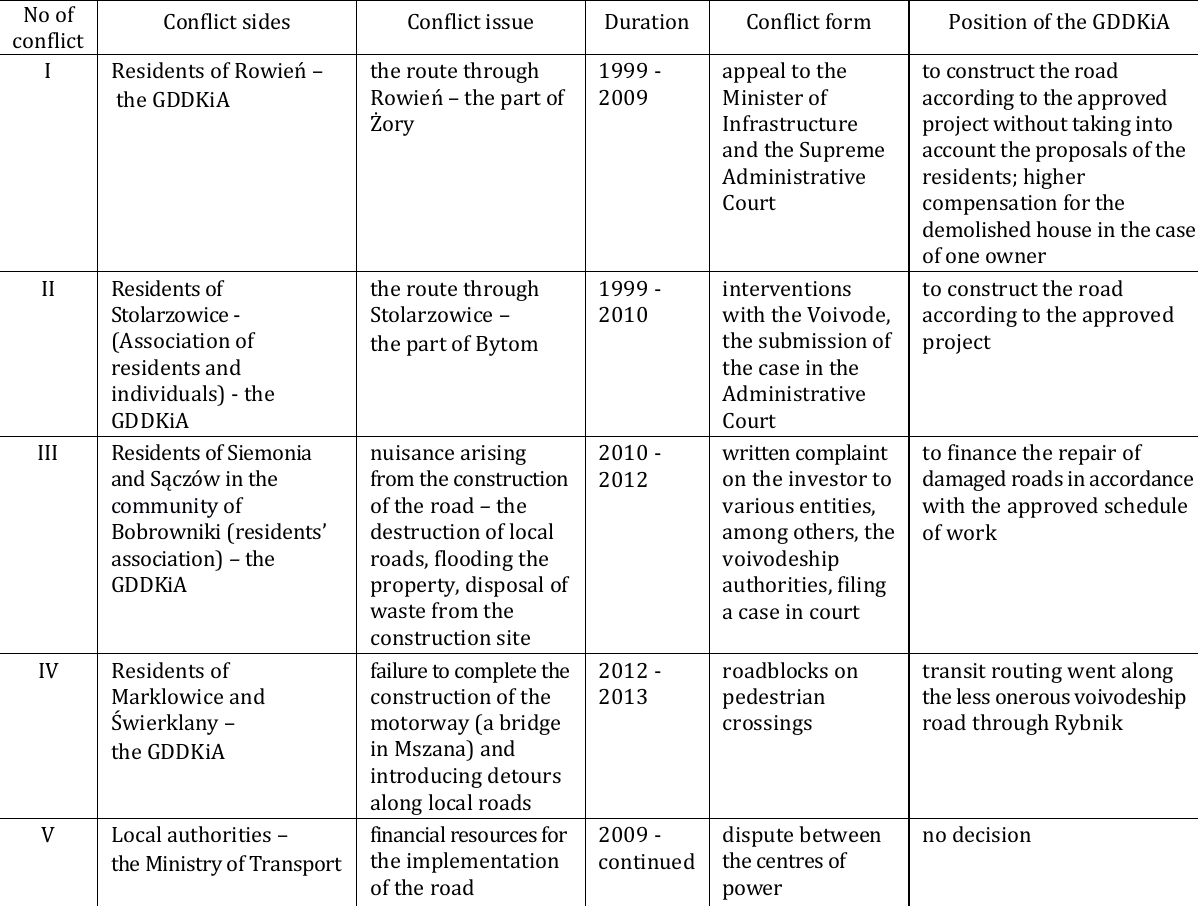
Table 1. Comparison of conflicts related to the construction of the A1 motorway through the Silesian